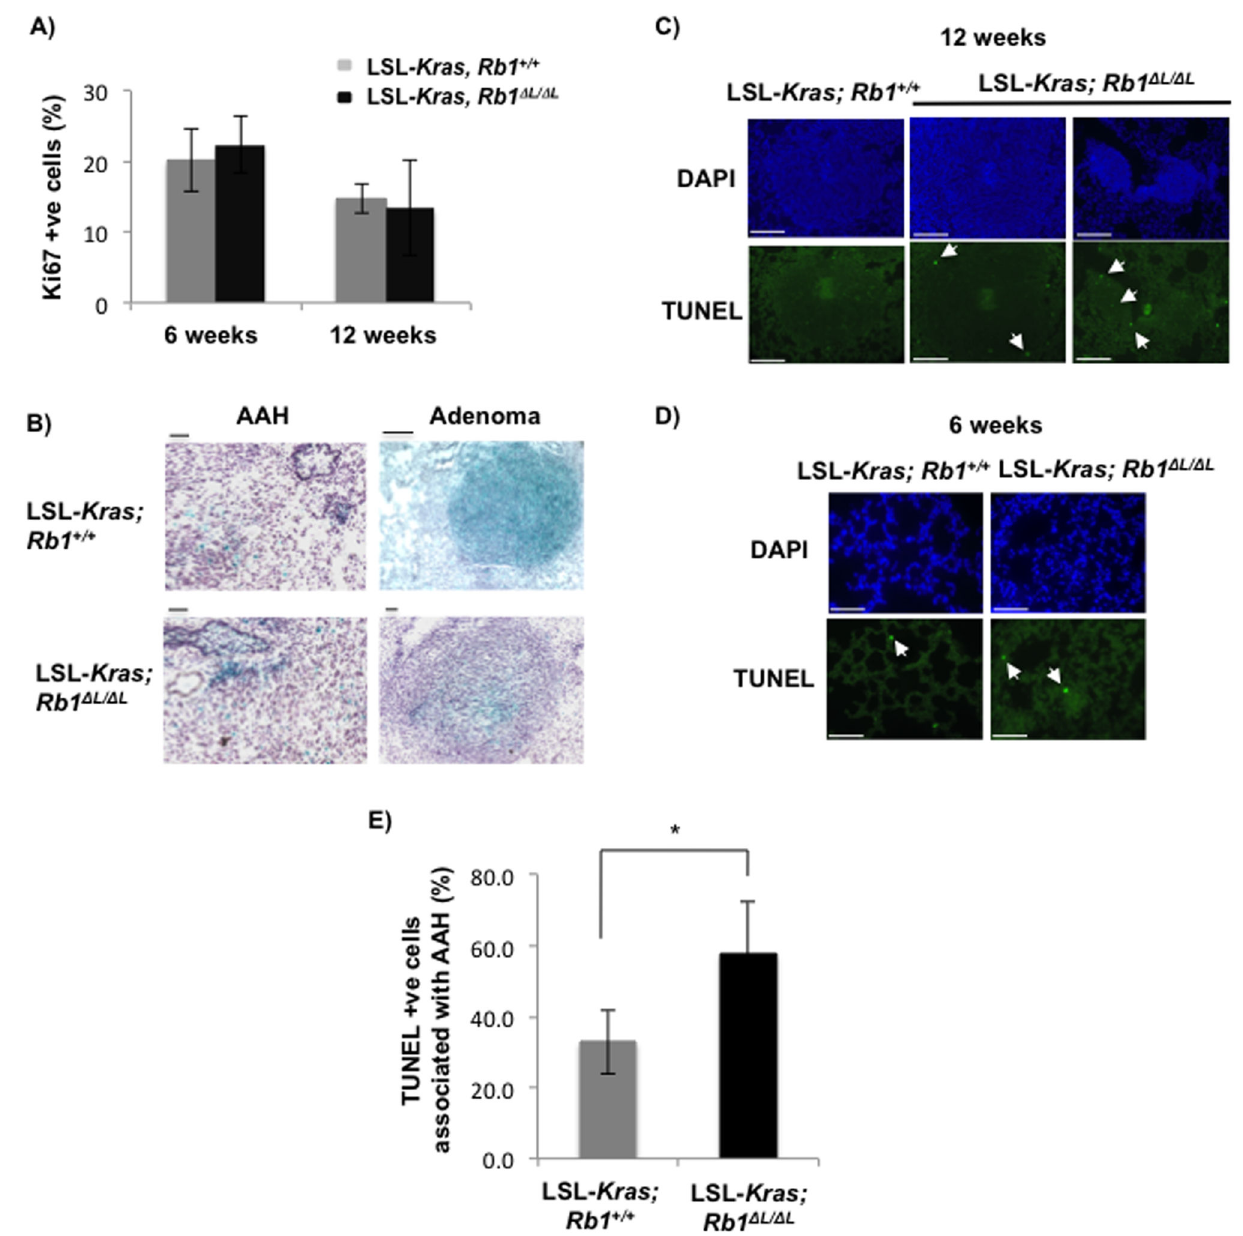
Figure 5. Elevated apoptosis in atypical adenomatous hyperplasia lesions from lungs of Rb1 ∆L/∆L mice expressing KrasG12D. Six to eight week old LSL- Kras; Rb1 +/+ and LSL- Kras; Rb1 ∆L/∆L mice were infected intra-nasally with Ad-Cre to activate the oncogenic KrasG12D. Characteristics of lung tumors at six and 12 weeks post Ad-Cre infection were assessed. ( A ) Quantitation of Ki67 positive cells in the adenomas from LSL- Kras; Rb1 +/+ and LSL- Kras; Rb1 ∆L/∆L lungs at the indicated time points. ( B ) Senescence associated β-galactosidase staining of cryo-sections from LSL- Kras; Rb1 +/+ and LSL- Kras; Rb1 ∆L/∆L lungs at the indicated time points. Sections were counterstained with haematoxylin. Scale bars are 50 µm. ( C ) Representative TUNEL stained lung sections from LSL- Kras; Rb1 +/+ and LSL- Kras; Rb1 ∆L/∆L mice 12 weeks following Ad-Cre infection. DAPI was used to counterstain the nuclei. Arrowheads indicate a selection of TUNEL positive nuclei. ( D ) Representative TUNEL stained lung sections six weeks following Ad-Cre infection. DAPI was used to stain the nuclei. ( E ) Quantitation of TUNEL positive cells in B that are associated with atypical adenomatous hyperplasia lesions in LSL- Kras; Rb1 +/+ and LSL- Kras; Rb1 ∆L/∆L lungs. Means were compared by a t-test, statistically significant differences are shown by an asterisk (p=0.001). Scale bars are 50 µm.